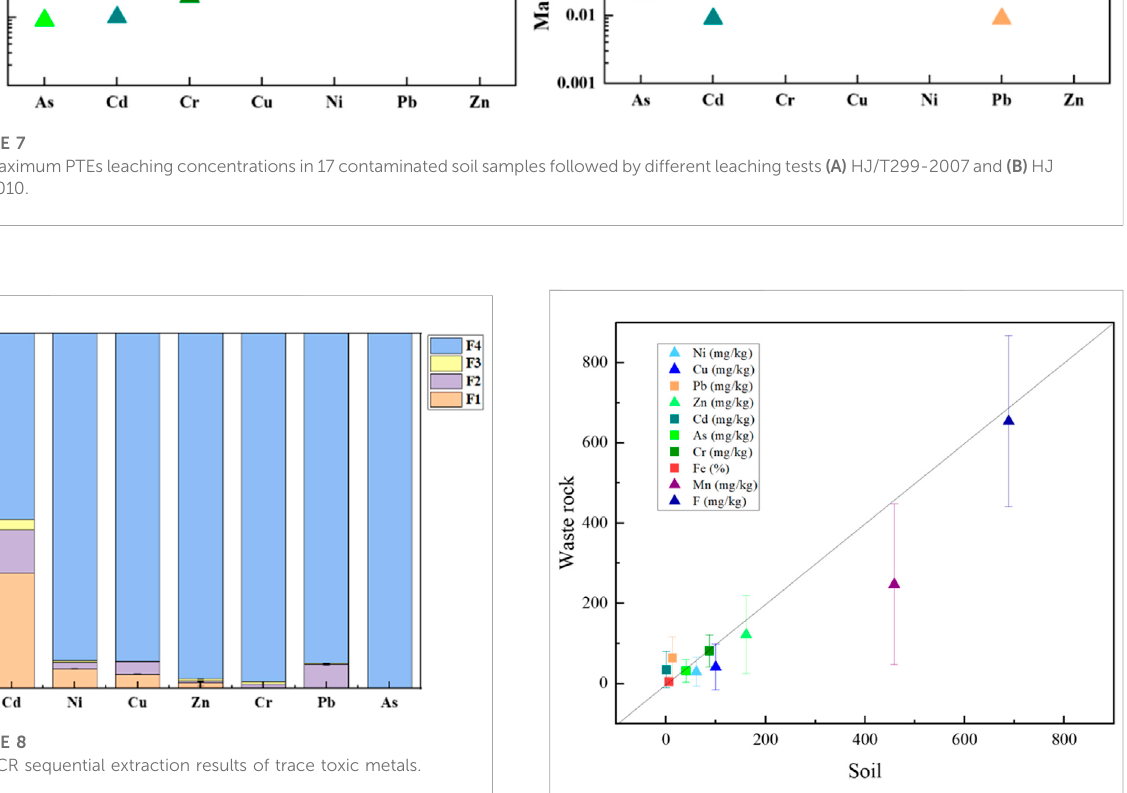
FIGURE 9 Comparison of PTEs contents in soil and waste